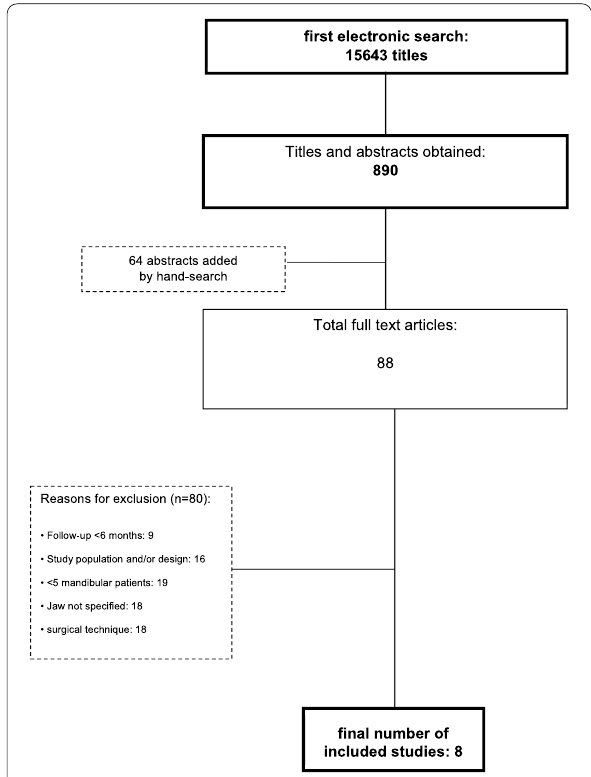
Fig. 1 Tree diagram of exclusion/inclusion of studies for this systematic review